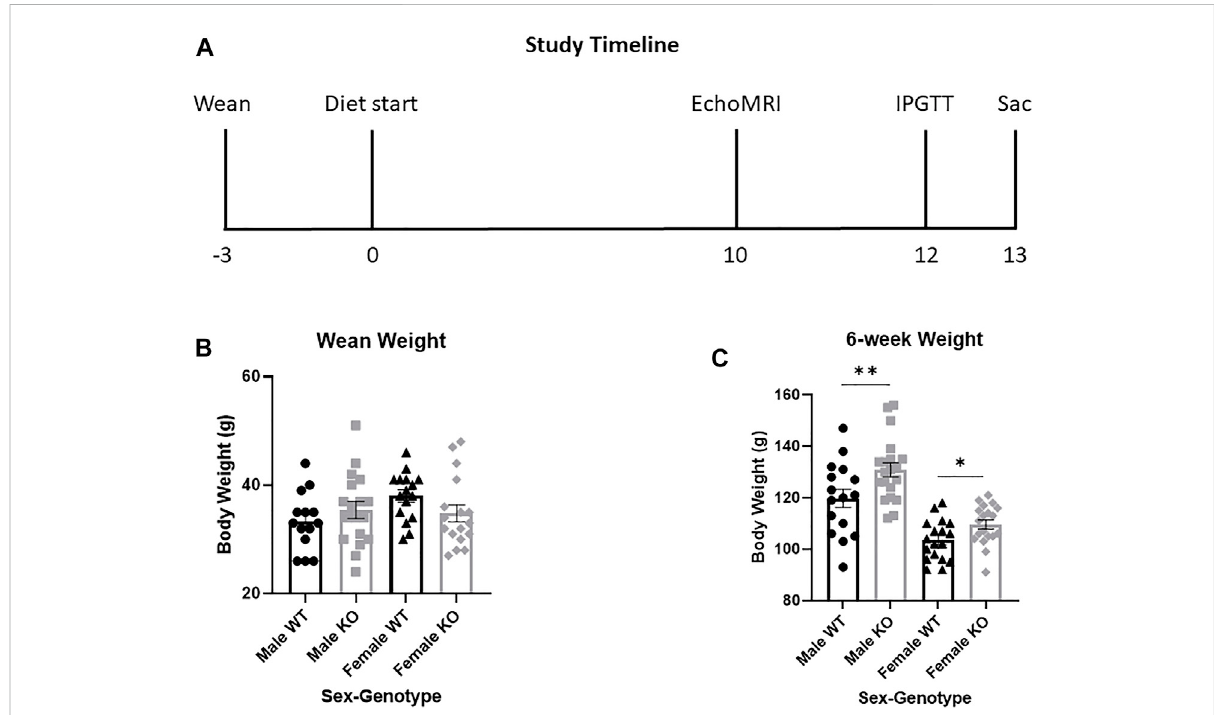
FIGURE 2 Study design and body weight in wild-type (WT, black) and Krtcap3 knock-out (KO, gray) rats prior to diet start. (A) Timeline outlining study design, with weeks relative to diet start shown. Metabolic phenotyping included EchoMRI analysis (EchoMRI), an intraperitoneal glucose tolerance test(IPGTT),andeuthanasia(Sac). (B) At timeofweanat3 weeksofage,therewerenodifferencesinbodyweight between WTmales(circle)andKO males(square),norbetweenWTfemales(triangle)andKOfemales(diamond).Bydietstartat6 weeksofage,however, (C) KOratsofbothsexes were signi fi cantly heavier than WT controls. * p < 0.05, ** p <